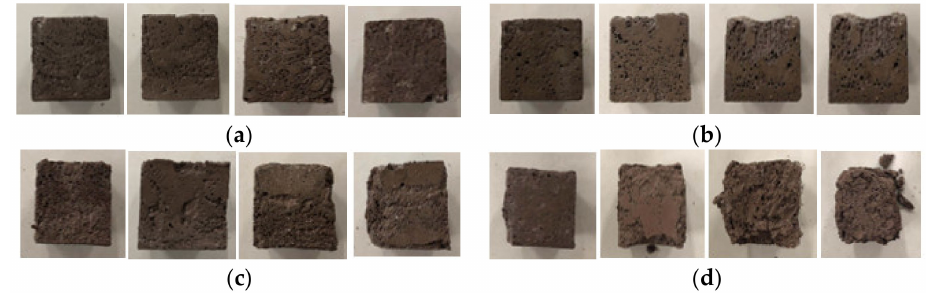
Figure 3. Corrosion morphology. ( a ) 50% high-sulphur fly ash, ( b ) 66.7% high-sulphur fly ash, ( c ) 75% high-sulphur fly ash, ( d ) 80% high-sulphur fly ash.